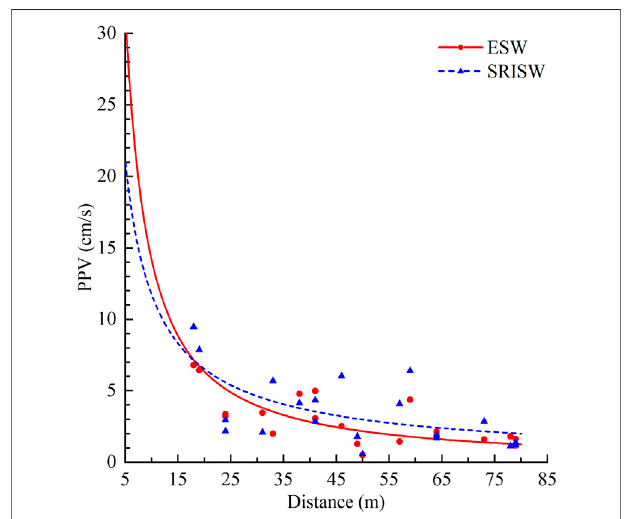
FIGURE 13 | PPV attenuation with distance of the separated seismic waves. FIGURE 14 | Dependence of average center frequency on distance of